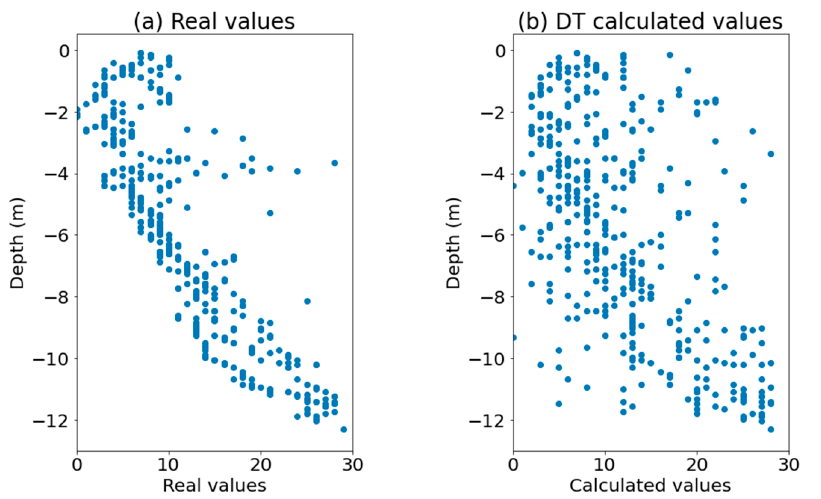
Figure 11. Real and calculated values for site 1. ( a ) Real values. ( b ) Values calculated by DT. ( c ) Values calculated using RF.